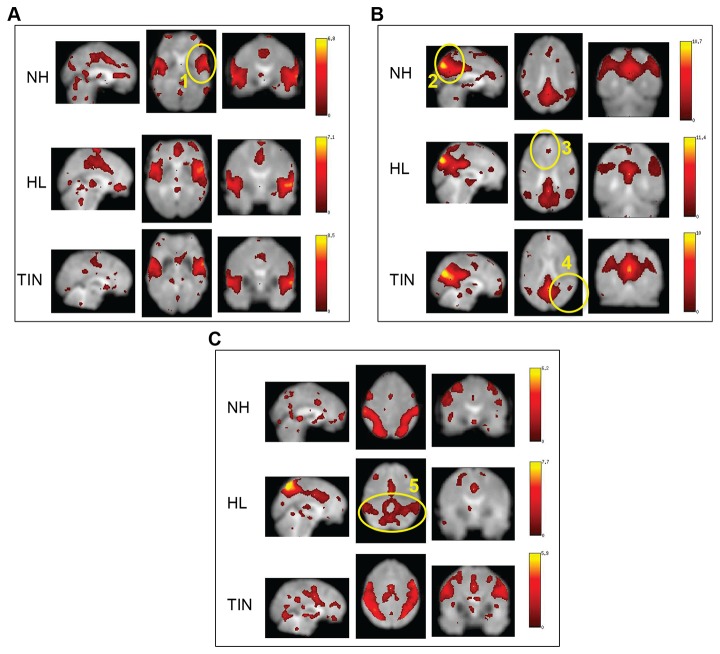
GIFT analysis results.
A) GIFT results of the auditory network. Visually, there were no large differences between groups in the primary auditory cortices (1).
B) GIFT results of the default mode network (DMN). Visually, the TIN and HL groups exhibited reduced response in the medial prefrontal cortex (3), whereas the inferior parietal lobules (4) appear to be least functionally coupled in the TIN group. The other main node of the network (posterior cingulate, 2) does not seem to be different in its connectivity across the groups.
C) GIFT results of the dorsal attention network (DAN). Group differences were not apparent. However, there is a somewhat decreased response in the intraparietal sulci (5) in the HL group.